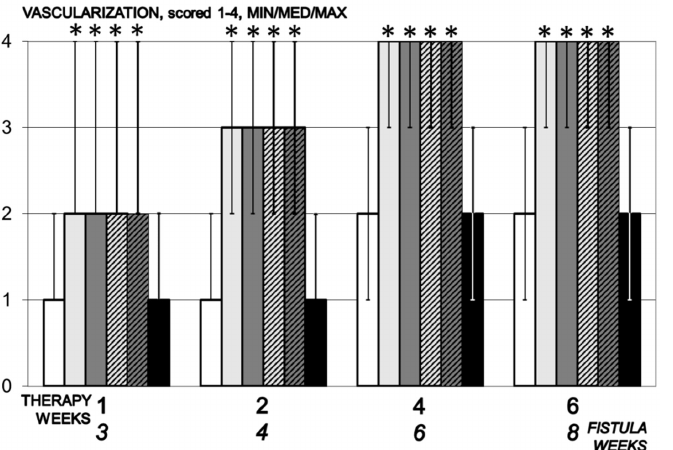
Figure 9. Vascularization, scored 1–4, min/med/max, time line. Therapy regimens starting at the day 14 after fistula creation (therapy day 0), included BPC 157 given once daily intraperitoneally, last application at 24 h before sacrifice, 10 µg/kg (light gray bars) or 10 ng/kg (dark gray bars) or given perorally, in drinking water 10 µg/kg/day (dashed light gray bars) or 10 ng/kg (dashed dark gray bars) until the sacrifice. Controls received simultaneously an equal volume of saline (5 mL/kg) intraperitoneally (white bars) or drinking water (12 mL/rat/day) (black bars). * p < 0.05, relative to control.